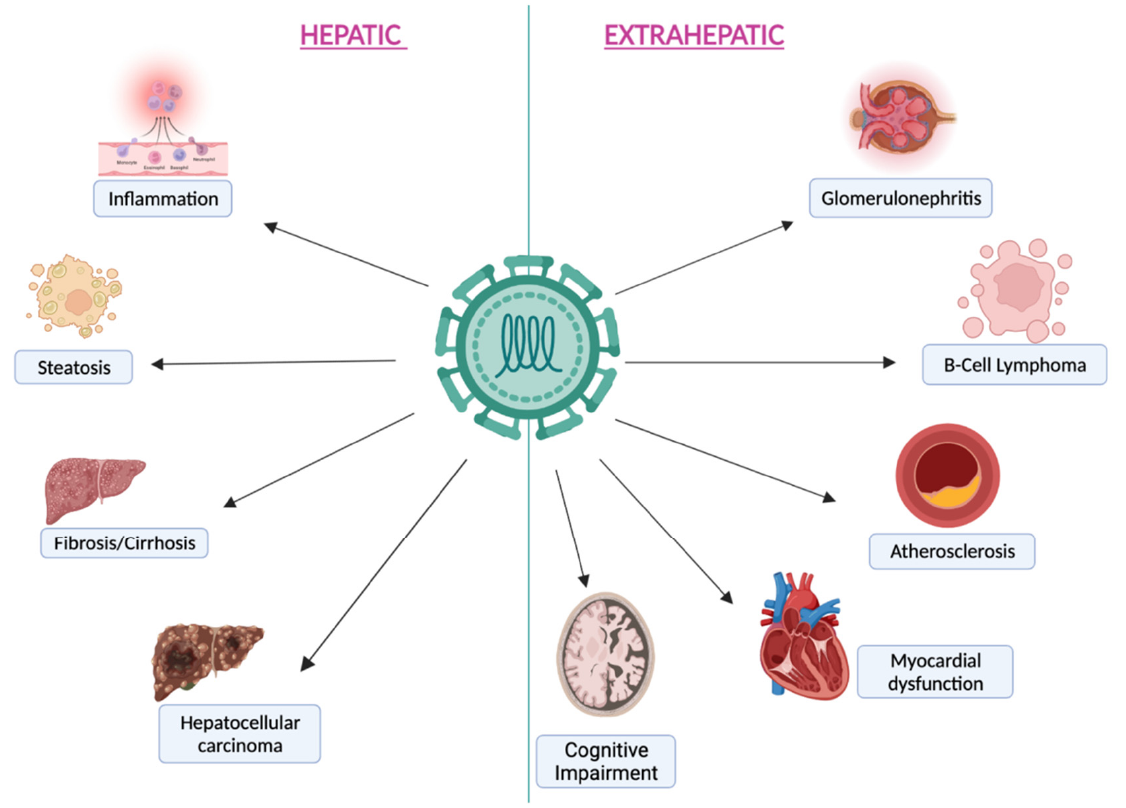
Figure 1. The principal hepatic and extra-hepatic manifestations during chronic HCV